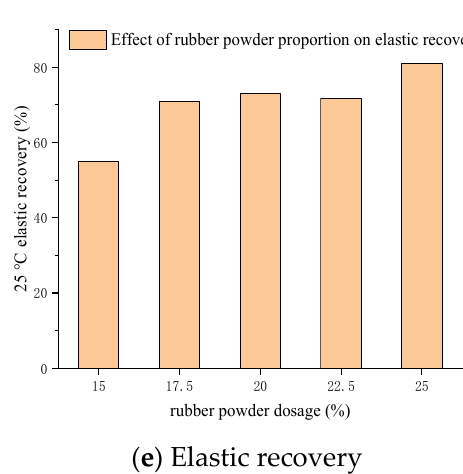
Figure 3. E ff ect of crumb rubber (CR) content on conventional tests result for 90#